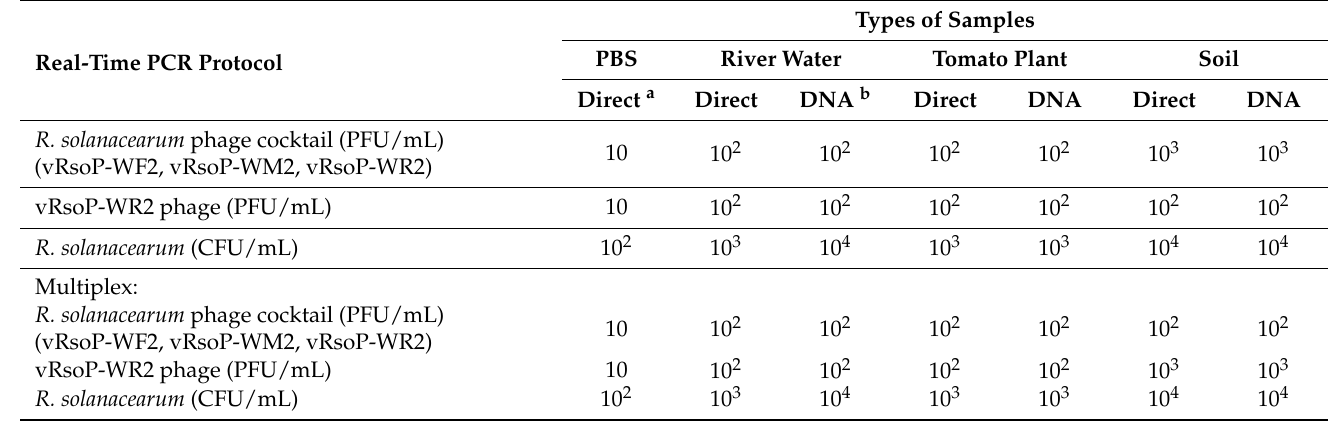
Table 2. Sensitivity of PCR protocols in the detection of Ralstonia solanacearum phages vRsoP-WF2, vRsoP-WM2, and vRsoP-WR2, and R. solanacearum in PBS, river water, tomato plant extracts, and soil from pathogen-free samples, with and without DNA purification.